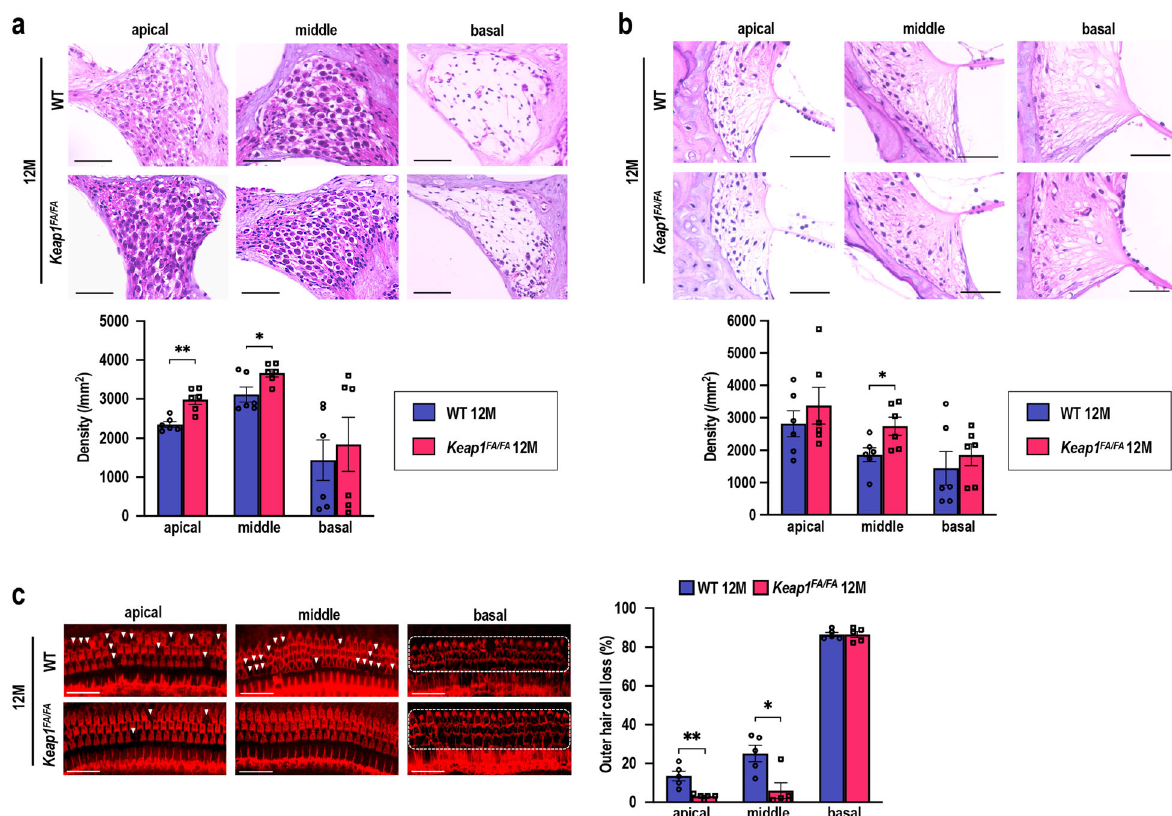
Fig. 8 Comparison of cochleae in the WT and Keap1 FA/FA mice at 12 months of age. a , b Cochlear histology at each turn. The SGN density ( a ) and density of the SL fi brocytes ( b ) are shown ( n = 6 in each group). c Images of the surface preparation of the hair cells. Missing OHCs are indicated with white arrowheads. Almost all OHCs at the basal turns are missing, as indicated by the area circumscribed by the dashed line. Missing OHCs were quantitatively analyzed by evaluating 90 OHCs at each turn ( n = 5 in each group). Data represent the mean ± SEM. * P < 0.05, ** P < 0.01. Unpaired two-tailed Student ’ s t -test was applied. The samples of the WT mice at 12 months of age are the same as those shown in Fig. 2. Scale bars correspond to 50 μ m ( a , b ) and 40 μ m ( c